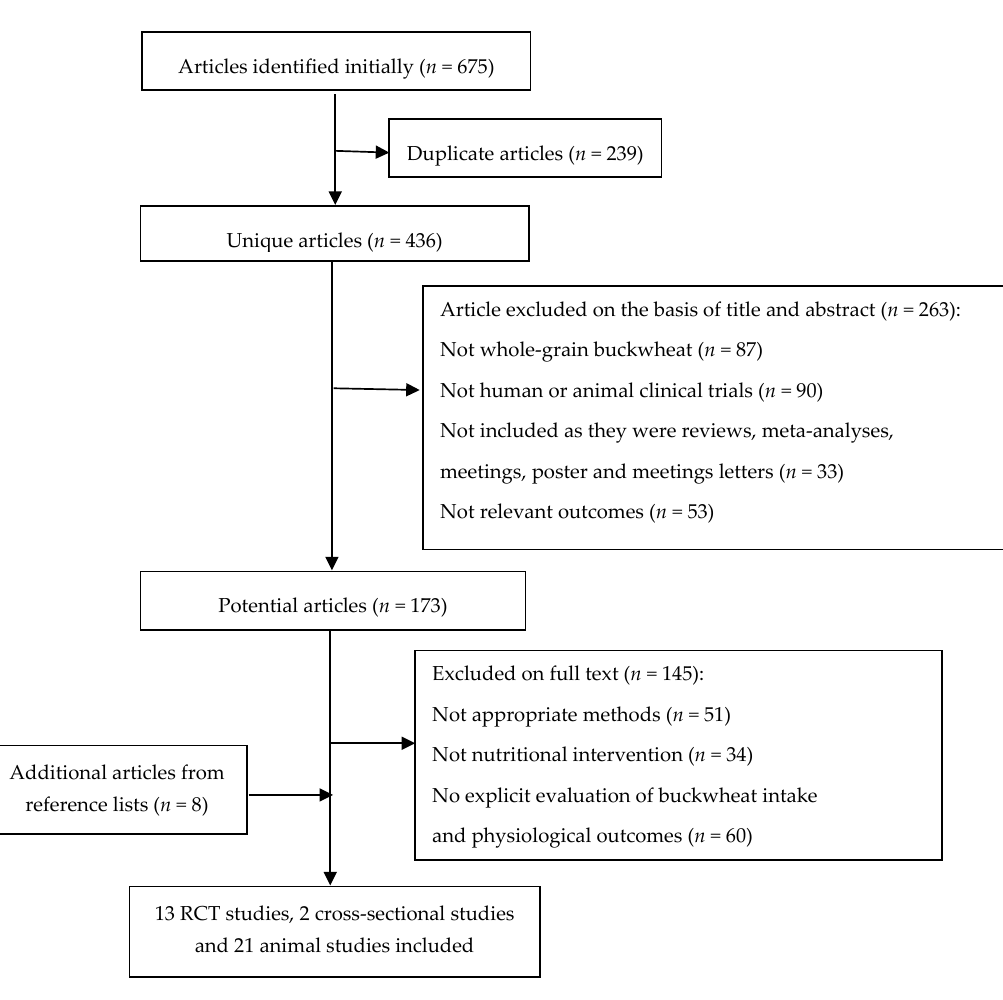
Figure 1. Flow diagram of article selection.